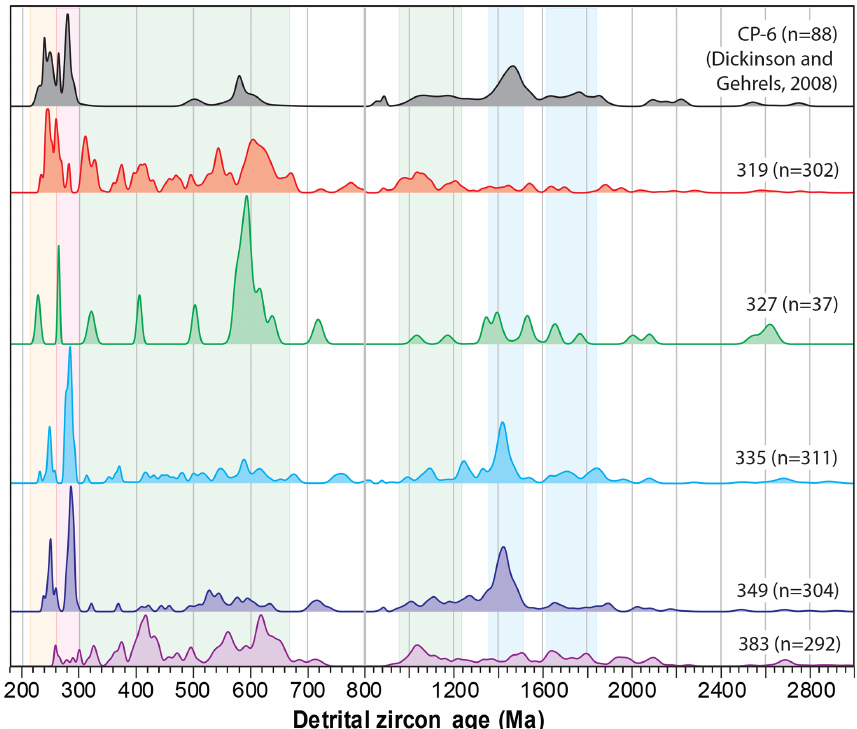
Figure 6. Probability density plots of detrital zircon ages from four samples from the Moenkopi Formation (lower four curves) as well as a Moenkopi sample from Dickinson and Gehrels (2008). Numbers of constituent analyses are shown for each sample. Samples 349-3, 335-1, 327-2, and 319-2, plus the sample from Dickinson and Gehrels (2008), are all from the Holbrook Member. Sample 383-2 is interpreted to belong to the Wupatki Member but has an age distribution that resembles lower Permian strata. Source regions are interpreted to include local basement rocks (blue bands), the Ouachita orogen (green bands), the East Mexico arc (red band), and the Late Permian–Triassic arc built along the Cordilleran margin (orange